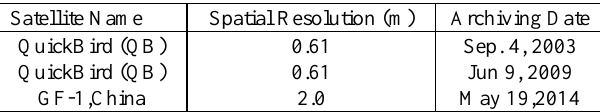
Table 2. Basic characteristics of remote sensing